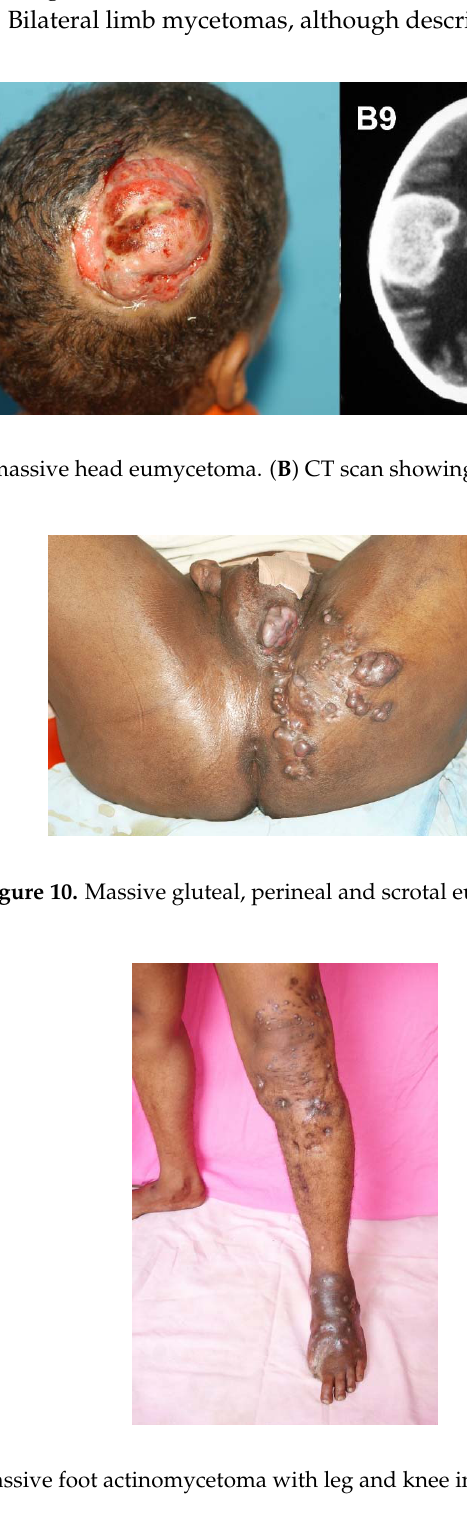
Figure 8. Hand eumycetoma with massive deformity.